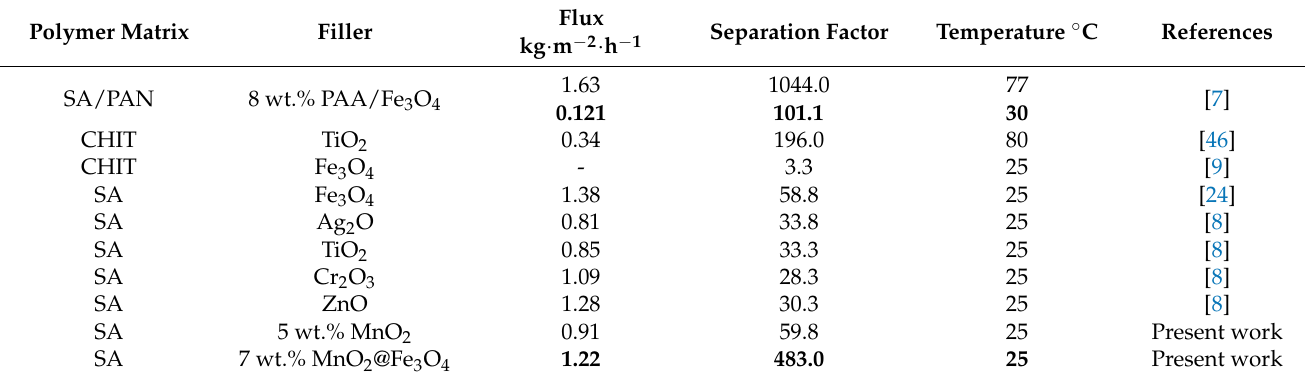
Table 1. The comparison of investigated membranes with other composite membranes reported in the literature, filled with various metal oxide particles, used in ethanol dehydration via pervaporation. Polymer Matrix Filler